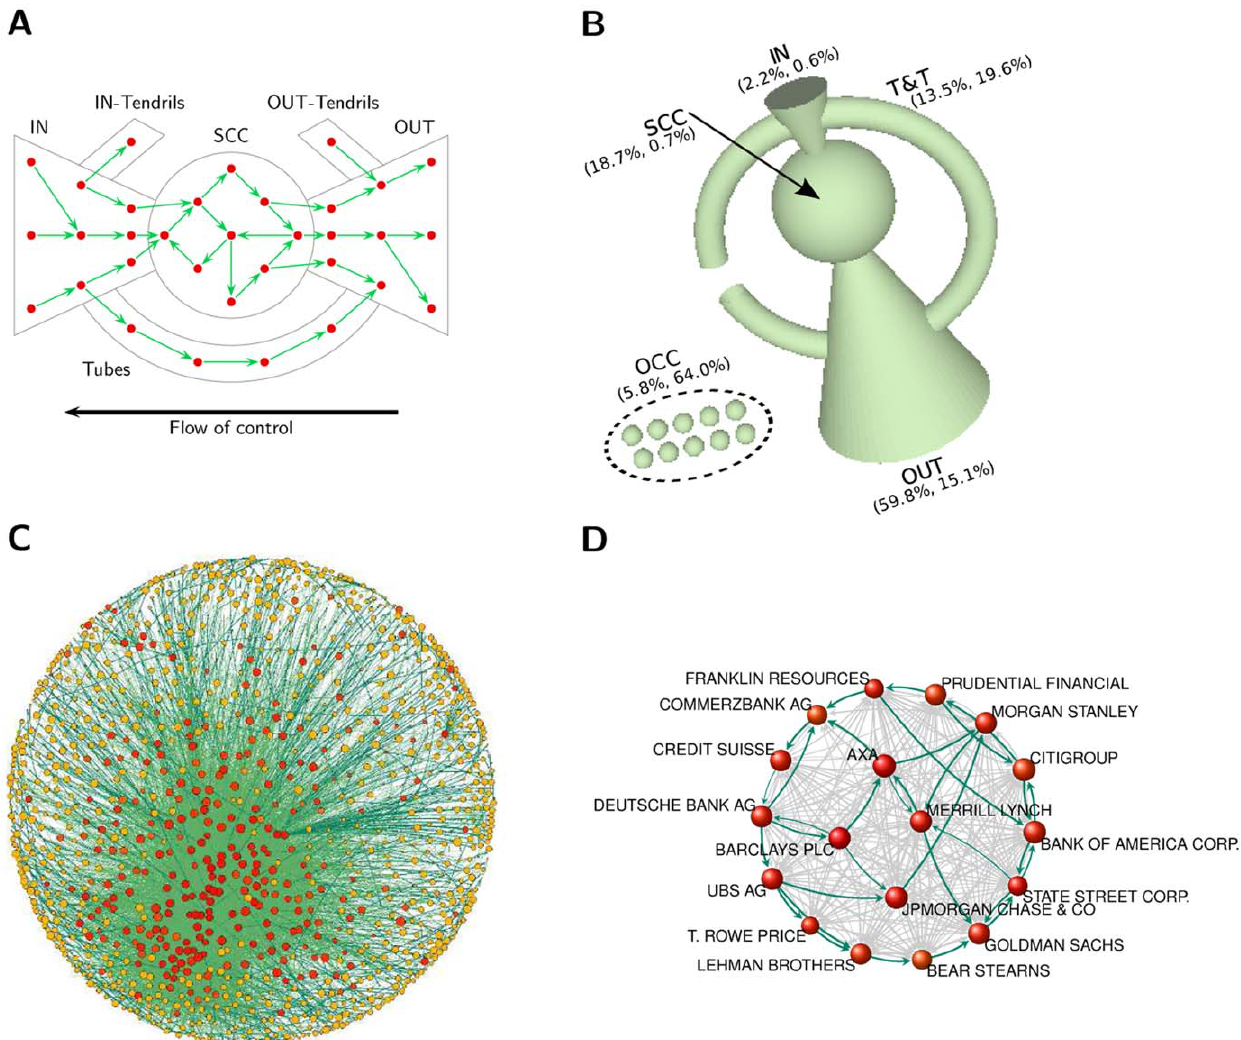
Figure 2. Network topology. ( A ) A bow-tie consists of in-section (IN), out-section (OUT), strongly connected component or core (SCC), and tubes and tendrils (T&T). ( B ) Bow-tie structure of the largest connected component (LCC) and other connected components (OCC). Each section volume scales logarithmically with the share of its TNCs operating revenue. In parenthesis, percentage of operating revenue and number of TNCs, cfr. Table 1. ( C ) SCC layout of the SCC (1318 nodes and 12191 links). Node size scales logarithmically with operation revenue, node color with network control (from yellow to red). Link color scales with weight. ( D ) Zoom on some major TNCs in the financial sector. Some cycles are highlighted.